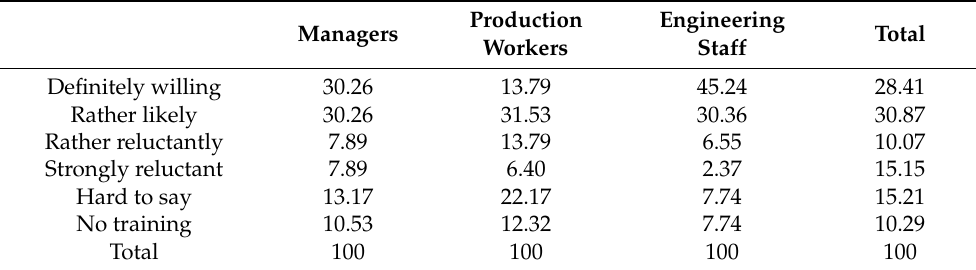
Table 8. Attitude towards participation in training vs. position in % (N = 447).